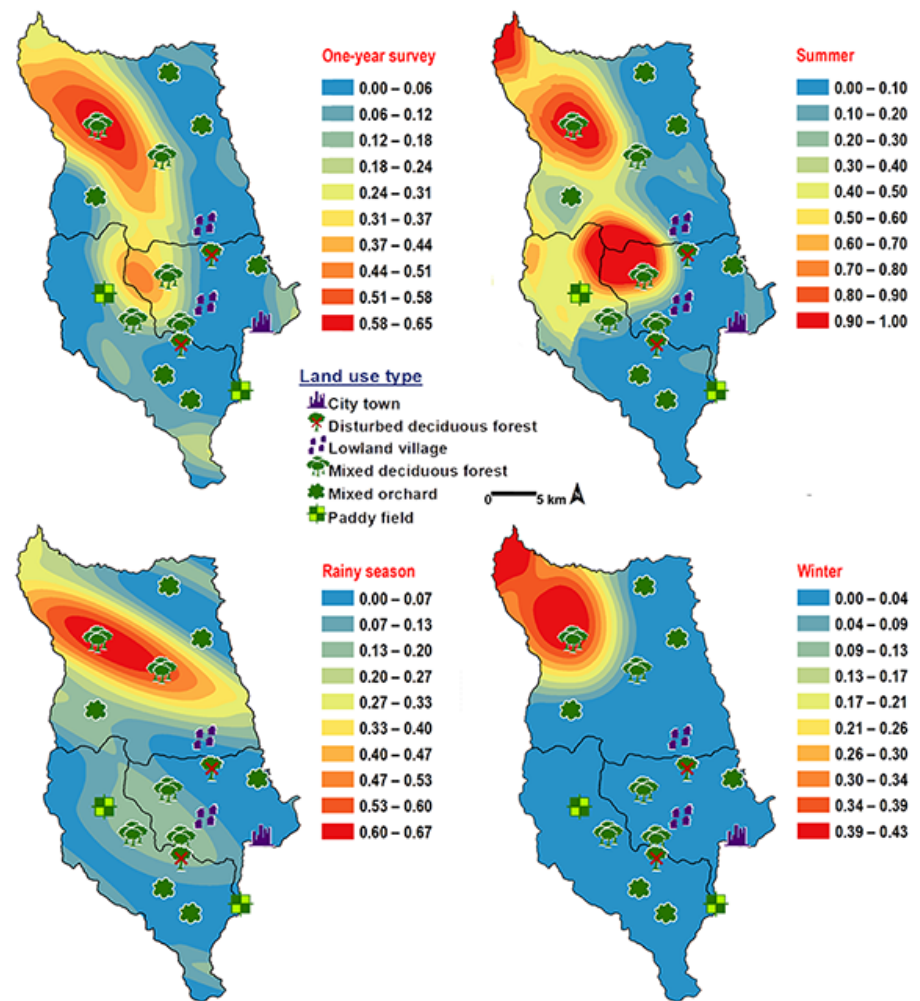
Figure 5. Predictive distribution maps of Chrysomya chani . The red areas symbolize the highest density of flies calculated by the analysis, while the blue areas indicate the lowest density. The scale corresponds to natural logarithm of (fly density +1).